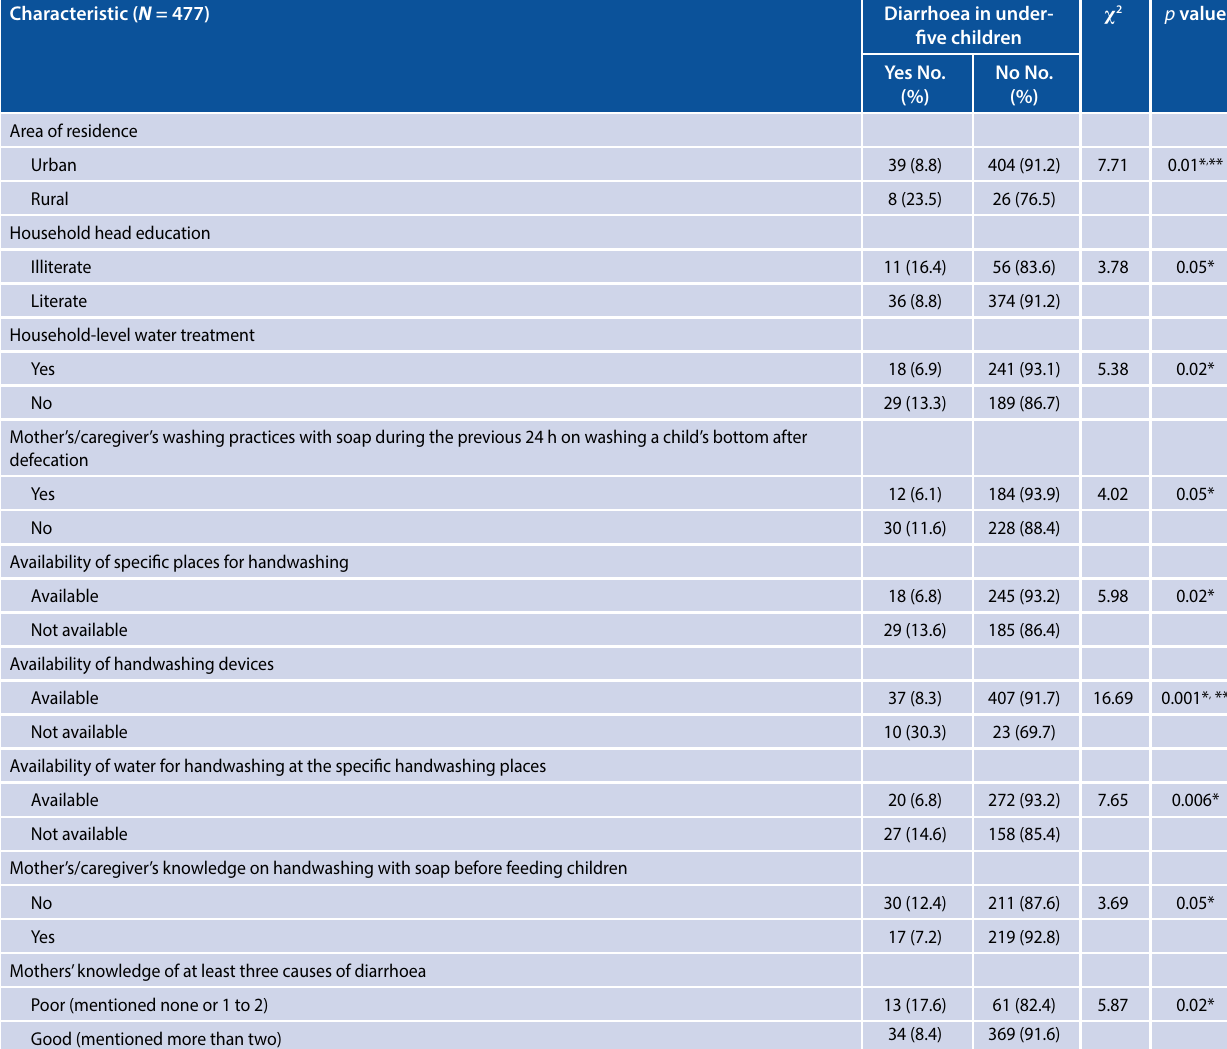
*Statistically significant with p value ≤ 0.05. **Fisher’s exact test.